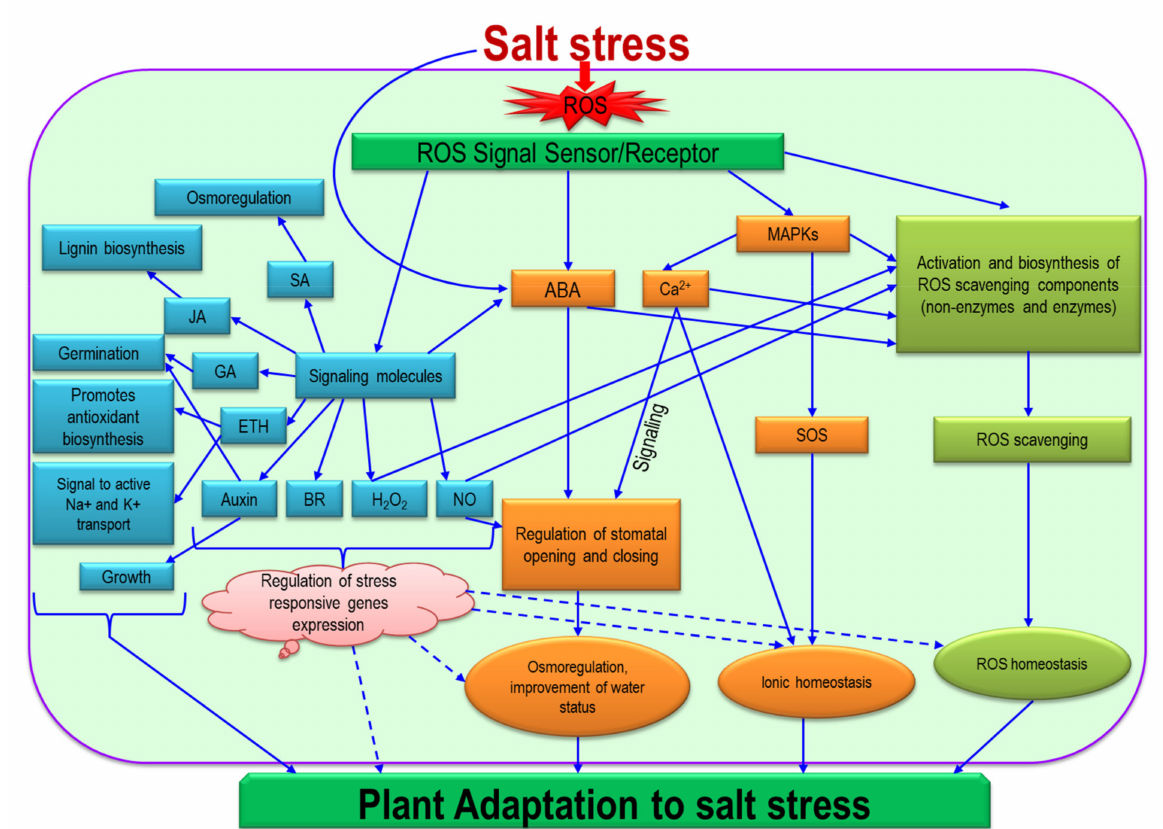
Figure 8. Common proposed ROS signaling pathways during plants’ response to salt stress. Under salt stress, ROS produc- tion induces mitogen-activated protein kinase (MAP) cascades which mediate different adaptive responses. MAPs, nitric oxide (NO), Ca 2+ and other signaling molecules have been suggested to be connected in activating antioxidant defense, stomatal movement, membrane properties and ionic homeostasis. The salt overly sensitive signaling (SOS) pathway interacting with other pathways functions in maintaining ionic homeostasis. The ROS-induced ABA production and ROS-induced activation of MAPs and Ca 2+ signal regulate stomatal opening and closing. ROS signal sensors/receptors can induce activation of biosynthesis/functioning of different hormones and signaling molecules such as salicylic acid (SA), jasmonic acid (JA), gibberellic acid (GA), ethylene (ETH), auxin, brassinosteroid (BR), H 2 O 2 and NO. These hor- mones/signaling molecules can interact with ROS, single or multiple hormones or signaling molecules; can interact with various signal cascades/pathways; and can regulate stress-responsive gene expression which modulates various metabolic and physiological functions, contributing to plant adaptation to salt stress. Dashed lines indicate the mechanisms which are not yet